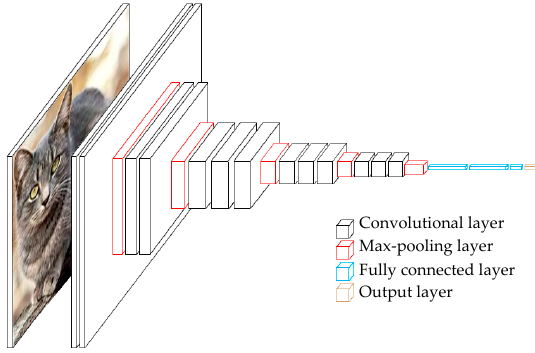
Figure 2. The Architecture of VGGNet. Table 1. Comparison between VGG_16 and Alphanumeric VGG net Configurations.